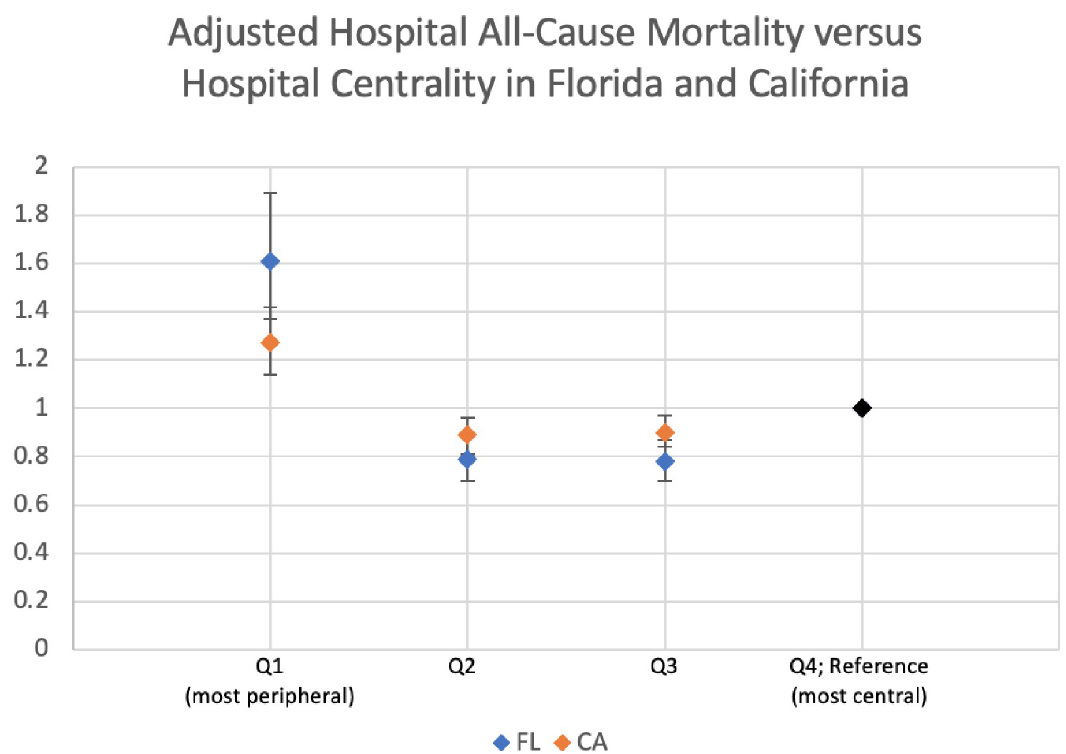
Fig 4. Adjusted hospital all–cause mortality versus hospital centrality in Florida and